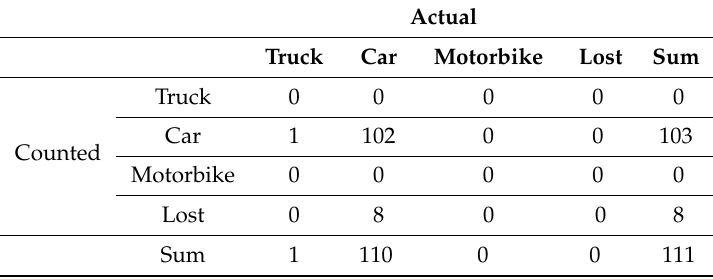
Table 3. Counting results per vehicle type from a toll station with 500 ms request interval.